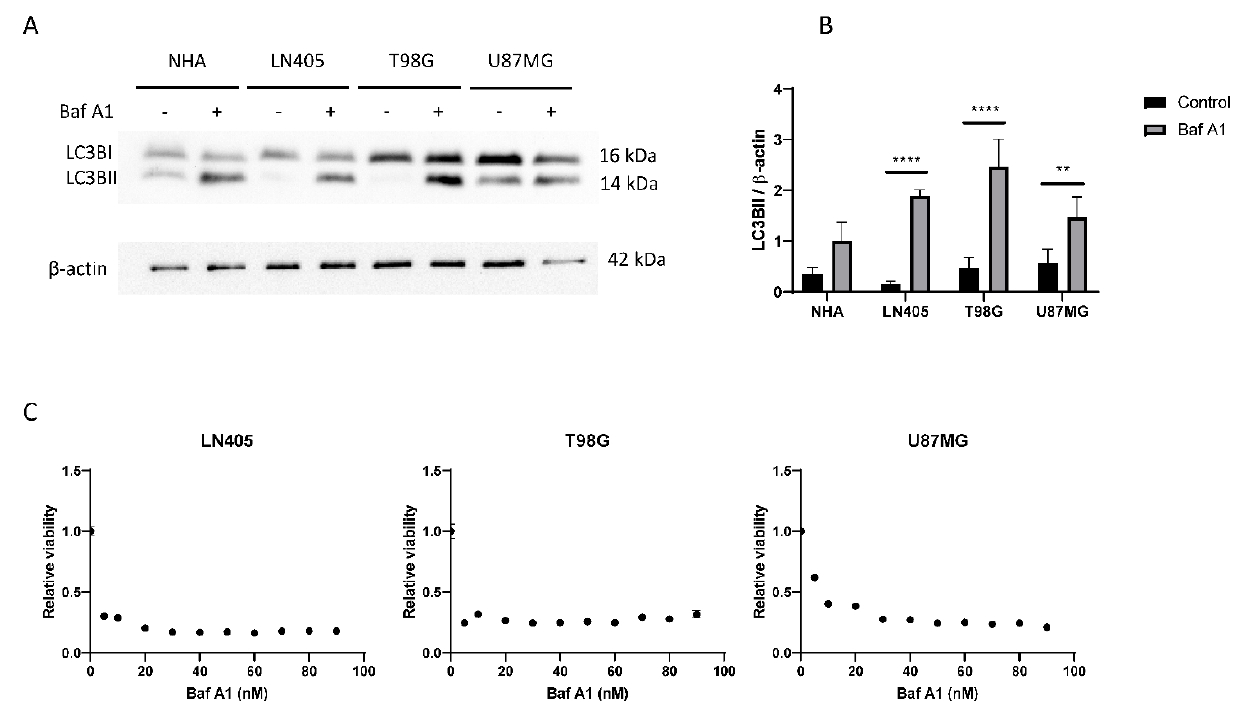
Figure 6. The autophagic flux is increased in GBM cell lines. ( A ) Representative image of western blot for LC3B and β -actin of human GBM cell lines and NHA cell lines after 6 h of 100 nM Baf A1 treatment. ( B ) Analysis of LC3BII western blot. Data are represented as mean ± SD (**) p < 0.01, (****) p < 0.0001 ( n = 3). ( C ) Analysis of viability in human GBM cell lines after Baf A1 treatment for 72 h. Data are represented as mean ± SD ( n = 3 of three independent experiments).